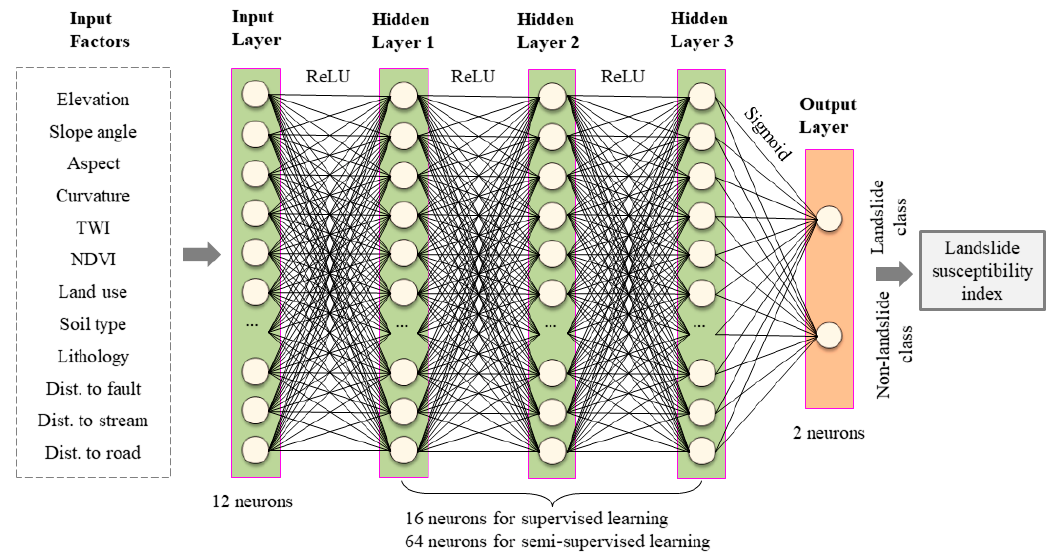
Figure 7. Illustration of the DNN for landslide susceptibility.